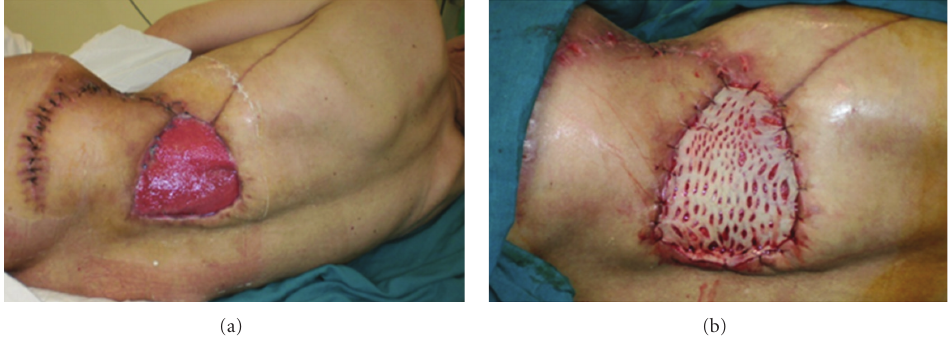
Figure 9: (a) Granulating wound, (b) skin graft.